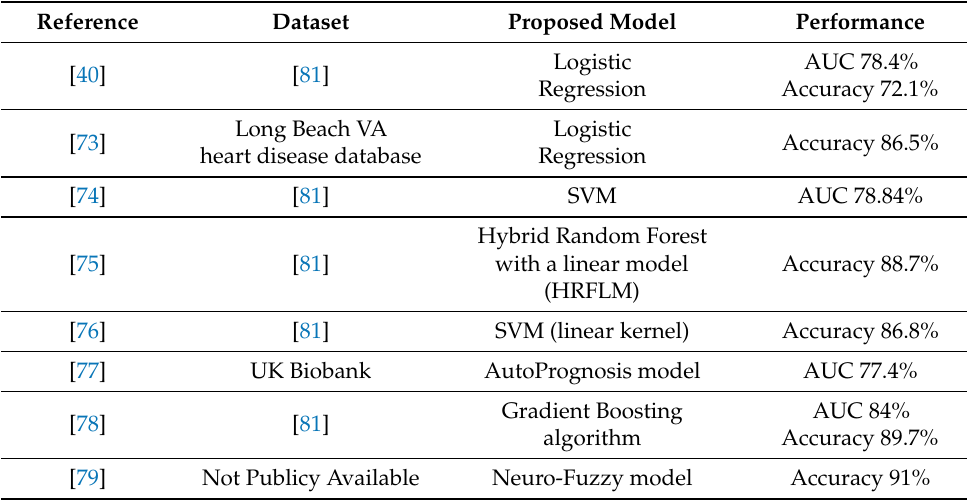
Table 11. An overview of recent studies for CVD risk prediction.